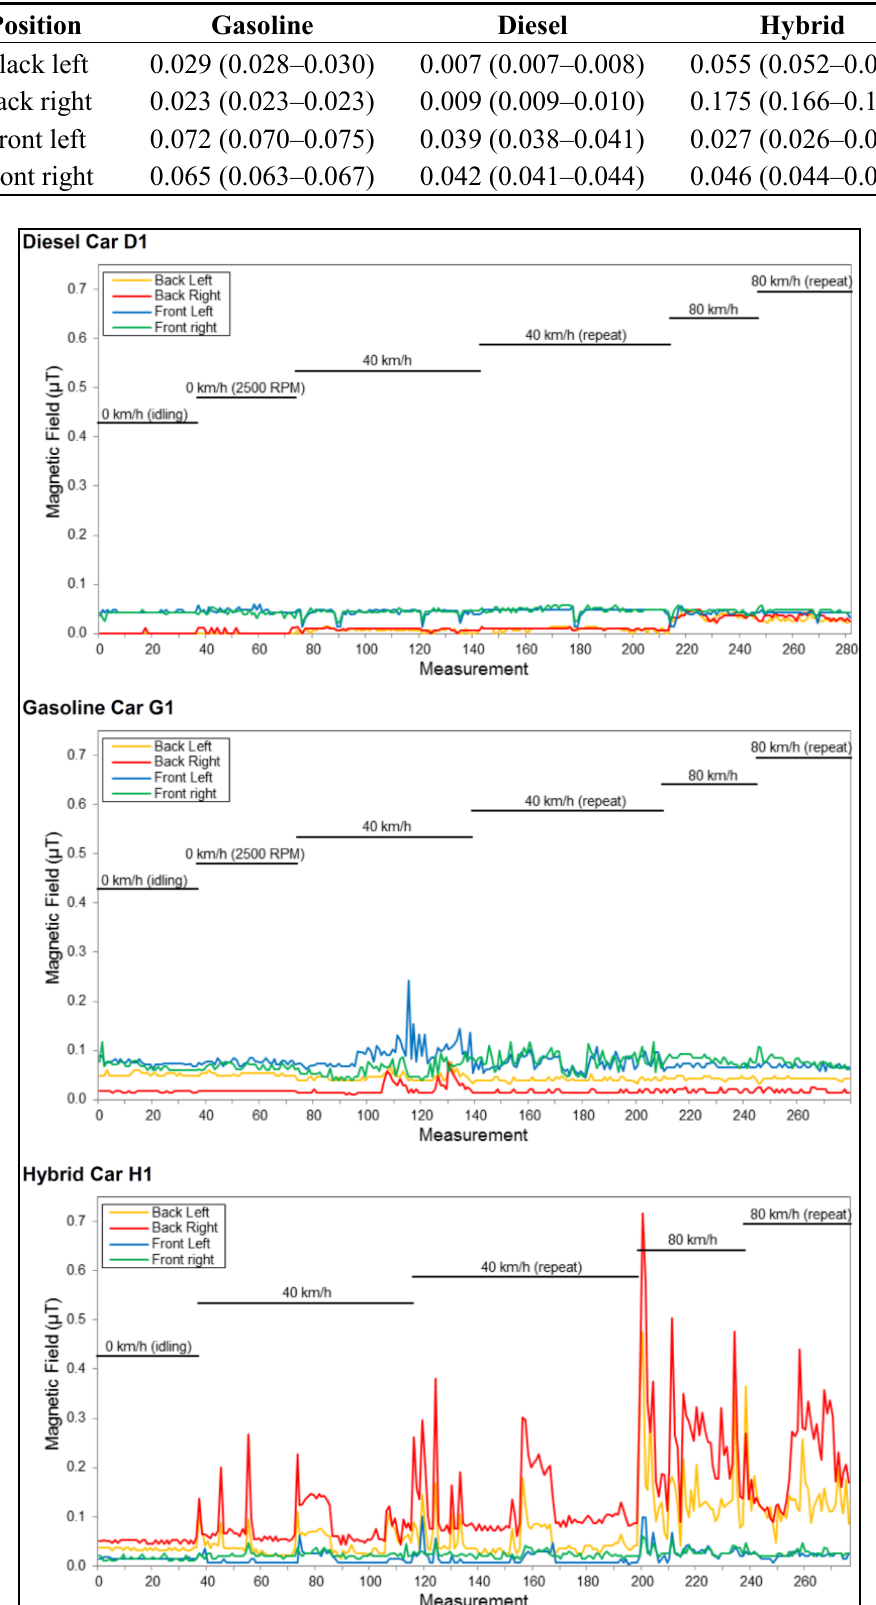
Figure 4. Examples of MF measurements by seat position for three cars; sampling rate of 1.5